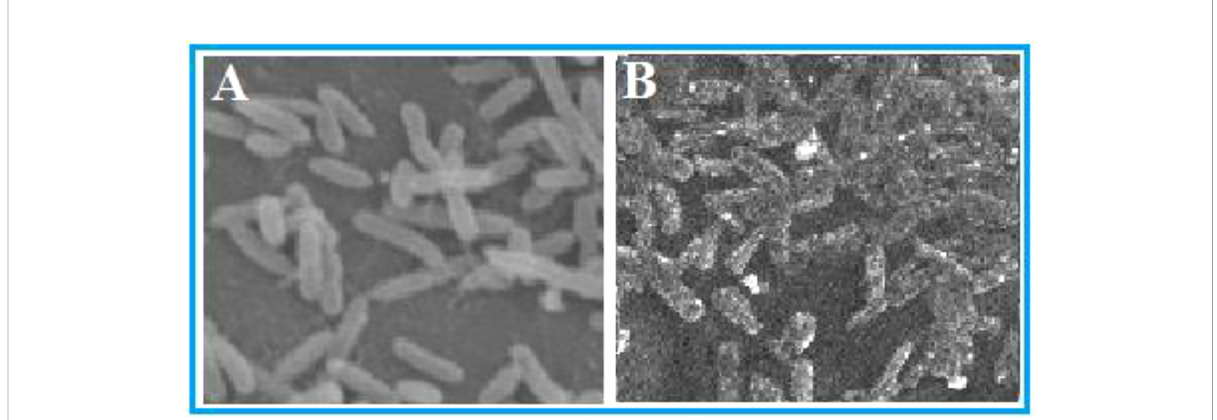
FIGURE 3 Morphological observations of Ralstonia solanacearum in SEM analysis. (A) Control: untreated bacterial cells and (B) cells treated with furoic acid compound.